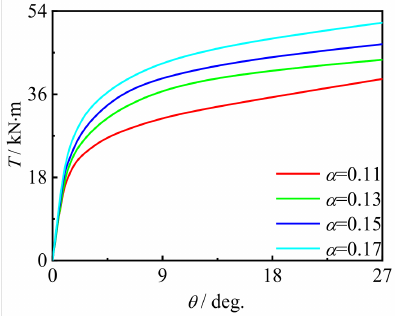
Figure 25. Effect of α on T - θ curve.